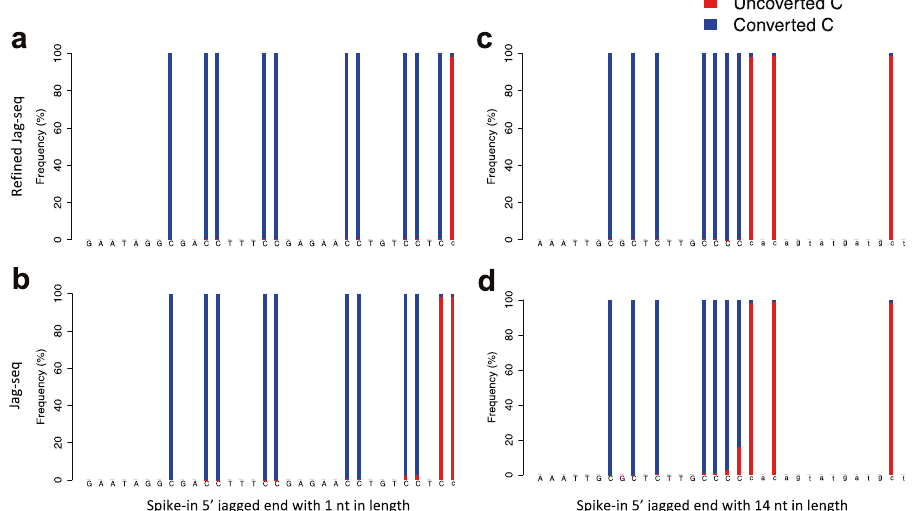
Fig. 2 Validation for spike-in molecules with 5 ′ protruding jagged ends. a – d Sequencing base compositions for spike-in sequence with known jagged ends. The partial sequence of the spiked-in sequences with a 1-nt and a 14-nt jagged end are indicated on the x-axis. The nucleotides denoted in the uppercase letters indicate that the sequences are in double-stranded form. The nucleotides in lowercase letters indicate that the sequences are newly fi lled during the end-repair process. Vertical bars with blue color and red color represent the frequencies of sequenced T and C, respectively. Sequencing results from the re fi ned ( a, c ) and original version ( b, d ) of Jag-seq are